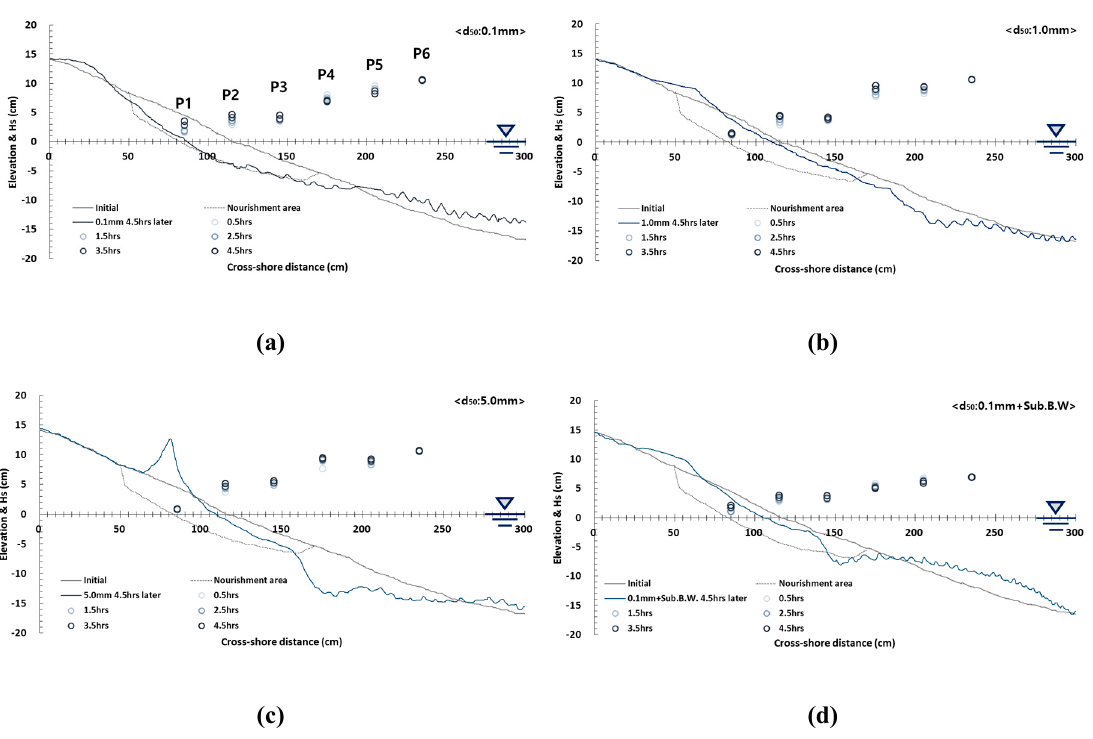
Figure 6. Wave deformation distribution with wind velocity; U: 0 m/s : ( a ) d 50 , 0.1mm, ( b ) d 50 , 1mm, ( c ) d 50 , 5mm, ( d ) d 50 , 0.1mm + Sub. B.W.